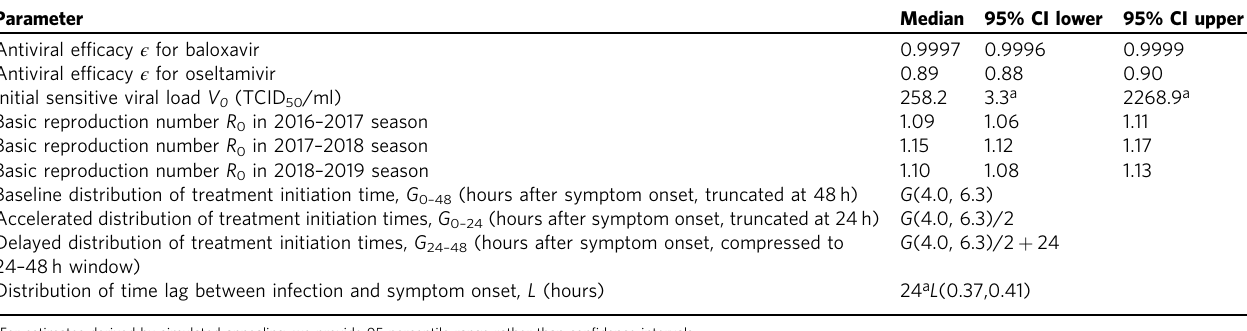
Table 1 Summary of key parameter estimates from fi tting within-host and between-host models to data.